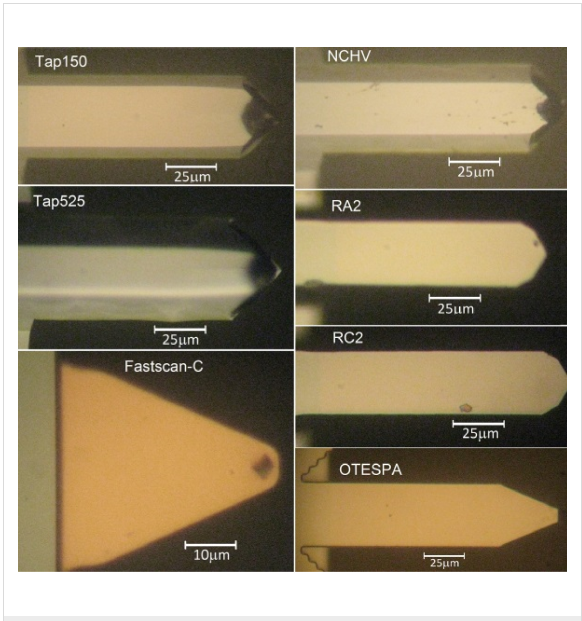
Figure 2: Optical images of the AFM cantilevers studied showing their plan view geometries (view from the tip side). Details of the cantilever dimensions are given in the Results section.